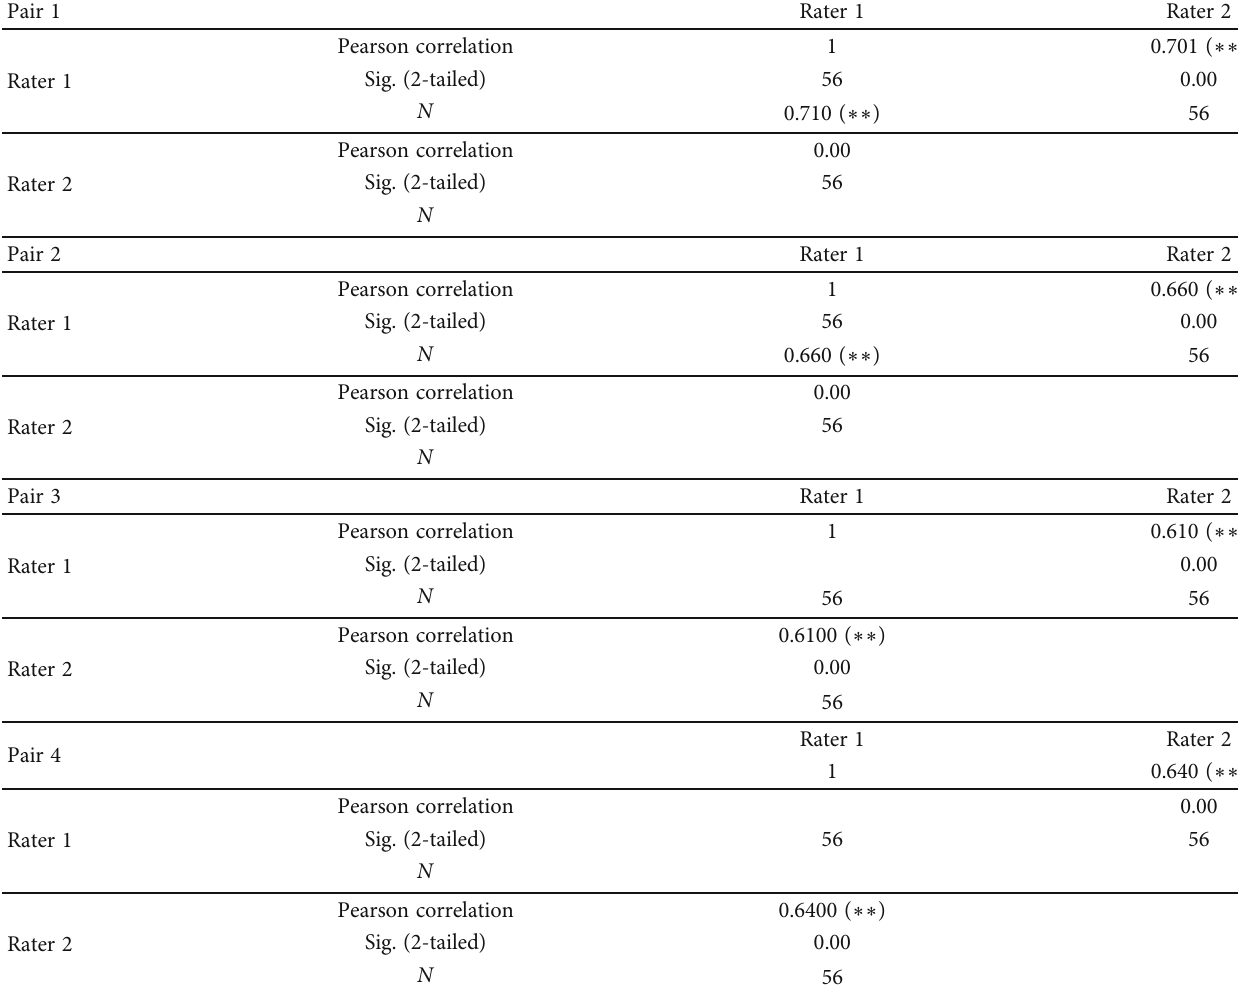
Table 1: Correlations in